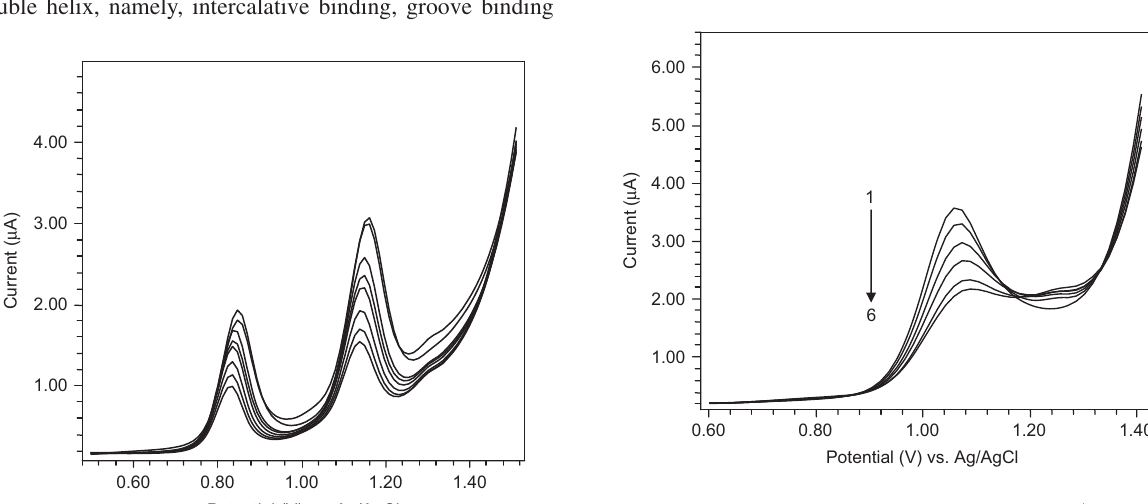
Figure 6 Differential pulse voltammogram of 1.4 × 10 -4 m of gati- fl oxacin in the absence (1) and presence of (2) 3.17 × 10 -4 m, (3) 3.7 × 10 -4 m , (4) 5.82 × 10 -4 m , (5) 7.94 × 10 -4 m , (6) 9.0 × 10 -4 m , DNA in Figure 5 Differential pulse voltammogram for the increasing